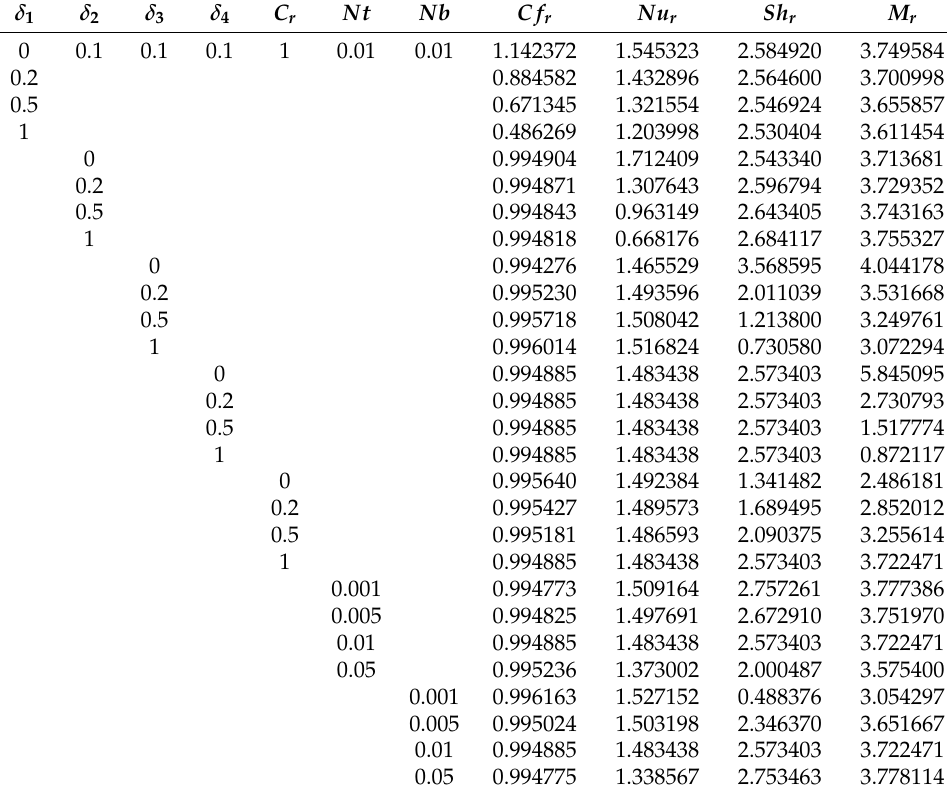
Table 6. Variation in quantities of interest with slip parameters, chemical reaction and nanofluid pa-